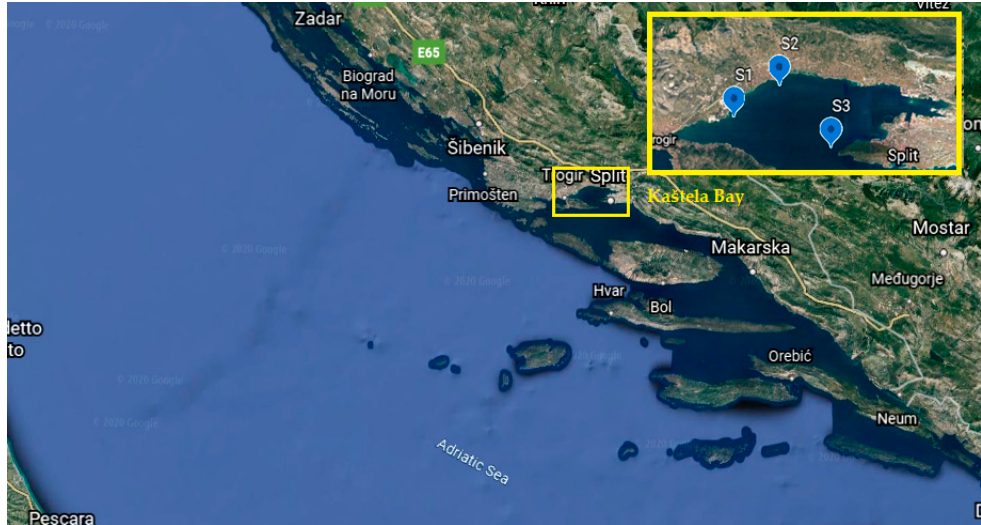
Figure 1. Map of sampling stations (S1–S3) in the Kaštela Bay (Adriatic Sea, Croatia). Longitude and latitude of the sampling stations S1 (16°18'21'':43°31'40''), S2 (16°21'12'': 43°33'01'), S3 (16°18'21'': 43°31'40'').